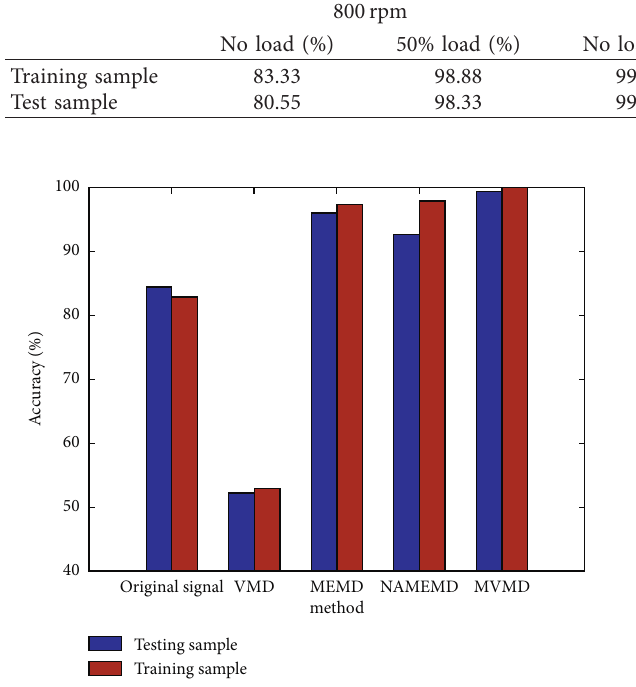
Figure 15: Comparison of different methods classification